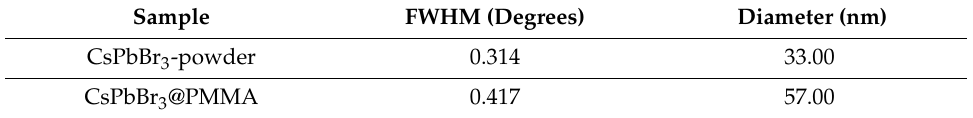
Table 1. Sizes of the CsPbBr 3 thin disk, calculated from the XRD patterns using the Scherrer equation.